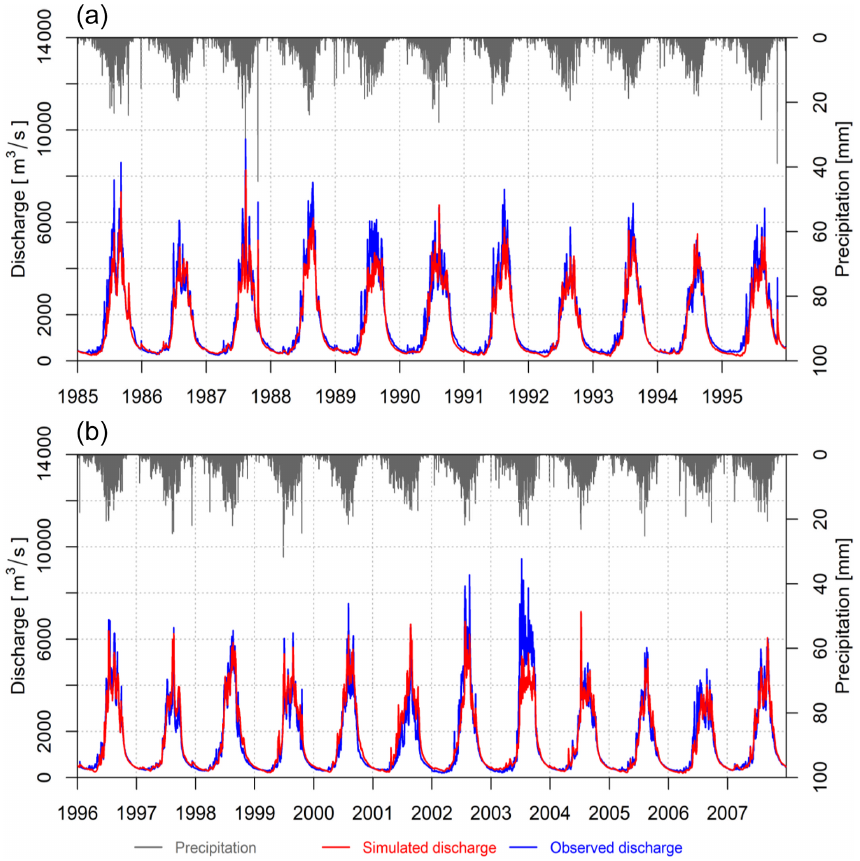
Figure 4. Calibration (a) and validation (b) of daily streamflow at